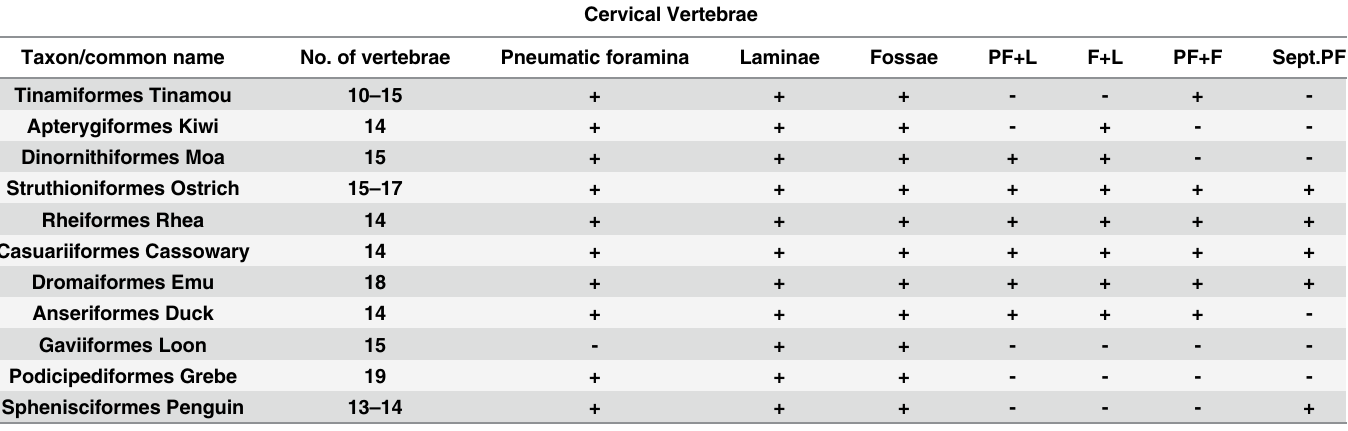
Table 2. Distribution of pneumatic elements on the cervical column per taxon. Presence (+) and absence (-) of pneumatic characters found on the cer- vical vertebrae from specimens of the 11 taxa studied. The penguin with the pneumatised vertebrae is Pygoscelis papua (NHMUK unregistered). For more details see S1 Table and S3 – S13 Tables. Abbreviations: PF, pneumatic foramina; F, fossae; L, laminae; Sept., septated.